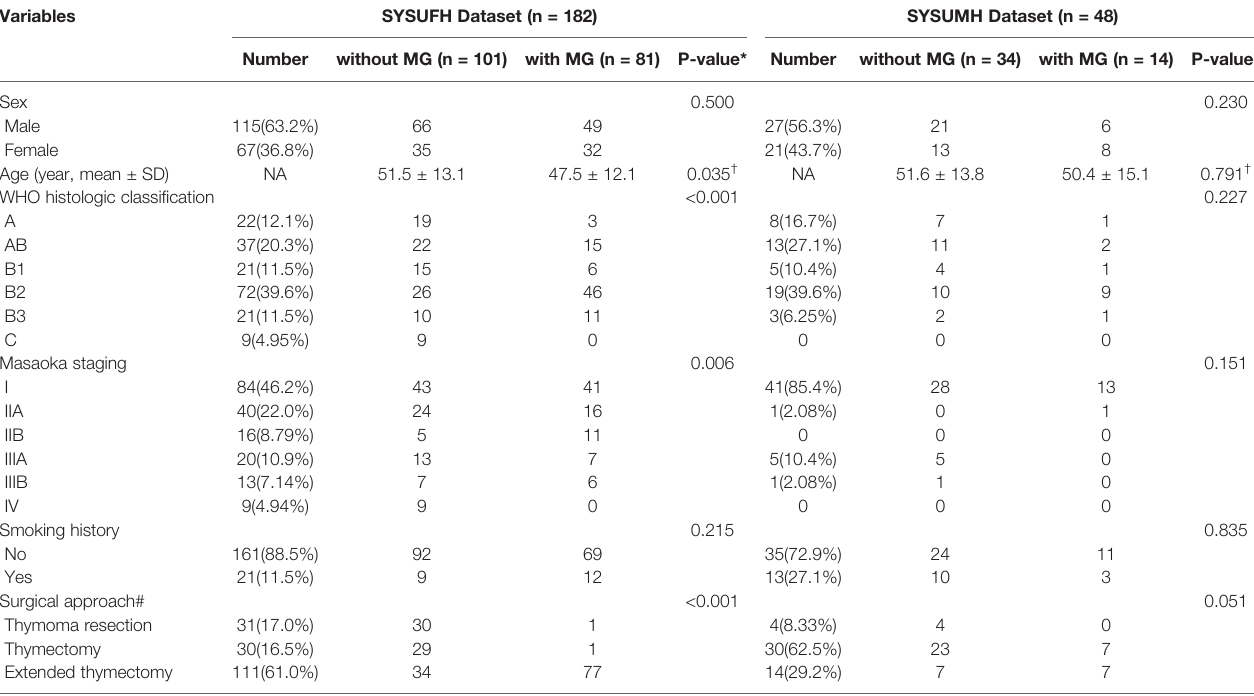
TABLE 1 | Baseline characteristic of the 230 patients with thymoma from two medical centers. Variables